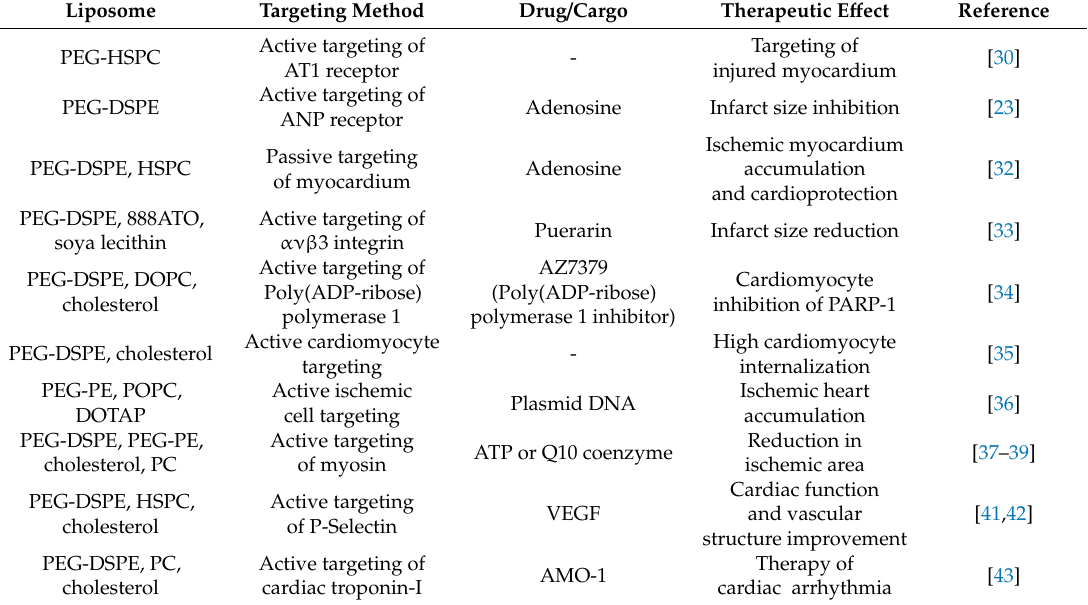
Table 1. Summary of liposomic nanoparticles and their therapeutic e ff